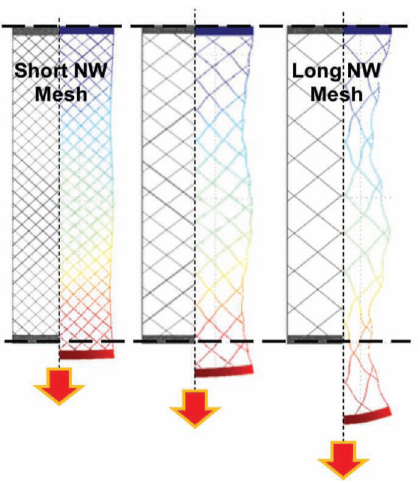
Figure 4. Numerical simulation results on deformation behavior of nanowire meshes with different densities under tensile strain. Reproduced with permission from ref. [38]. Copyright 2016, Elsevier.